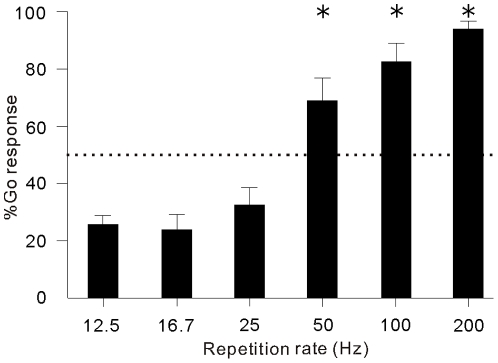
Percentages of Go responses in cats hearing click-trains at different repetition rates.Height of a black bar represents the mean % Go averaged over the sessions of 7 cats. Short horizontal line represents 2SE. Dotted line shows the 50% Go response. Asterisk marks the statistical significance of p<0.01(ANOVA followed by a Tukey-Kramer multi-comparison procedure).